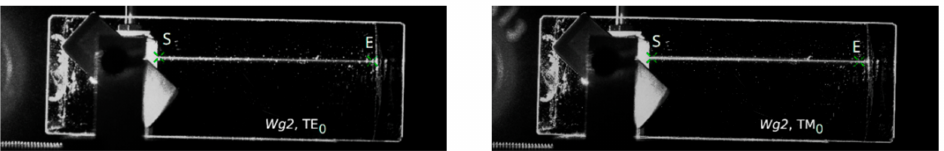
Figure 7. Streaks of scattered light accompanying propagation of TE 0 and TM 0 modes in the Wg1 waveguide. The endpoints (S and E) of scan lines are marked by a green cross.